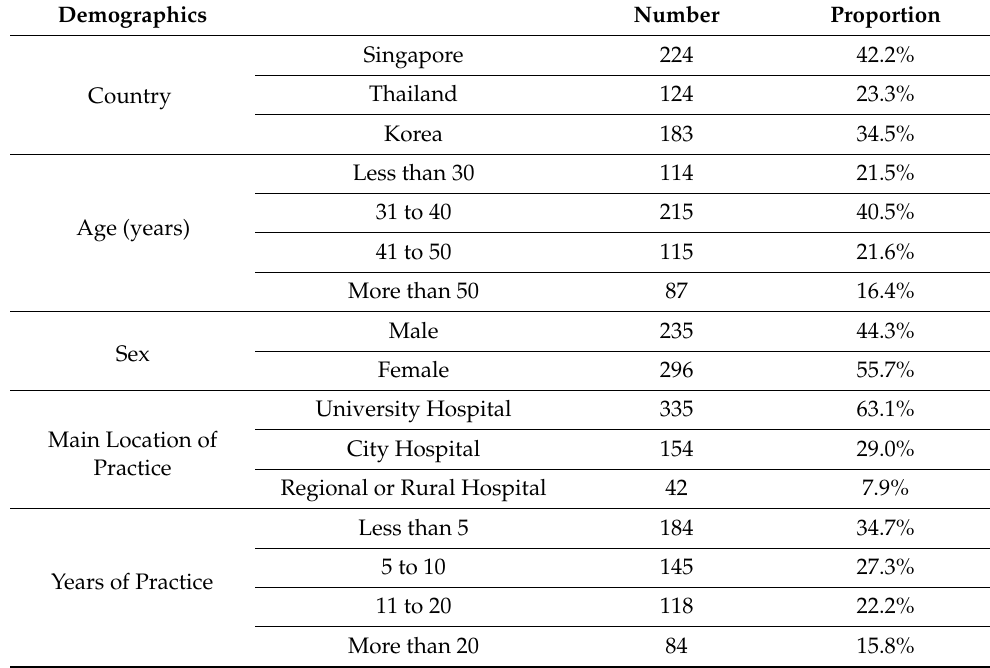
Table 1. Demographics of the survey